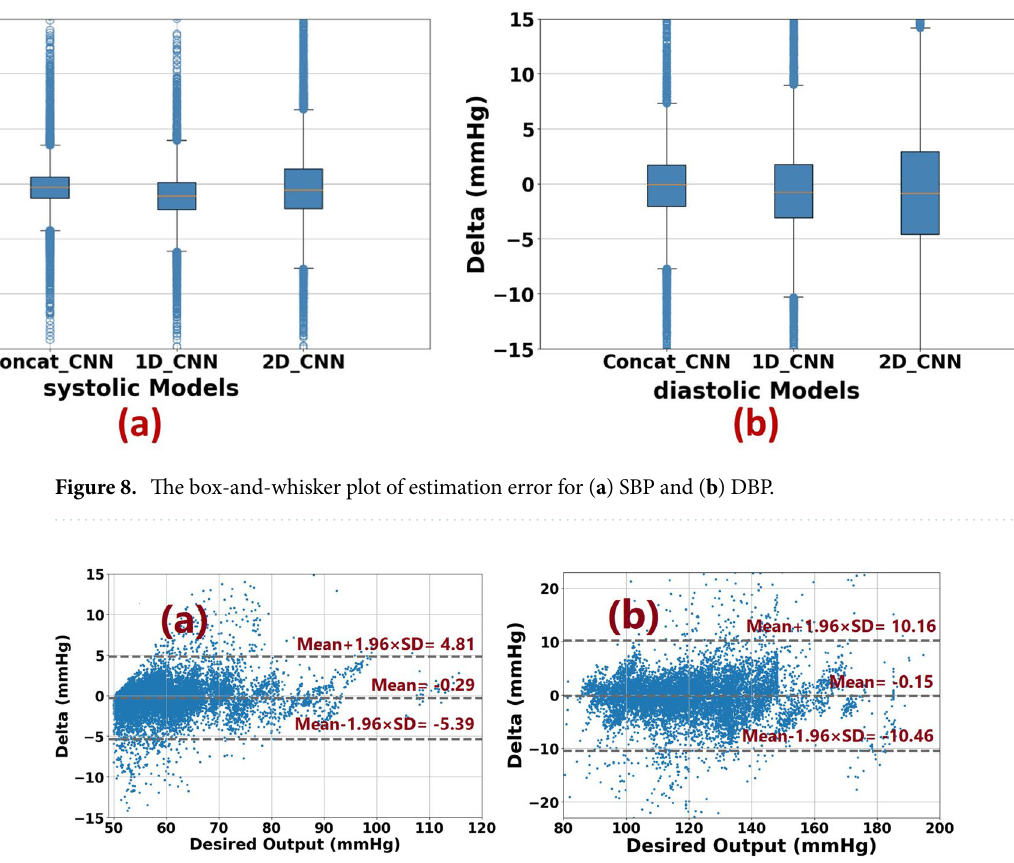
Figure 9. The Bland–Altman plot for DBP and SBP estimation by